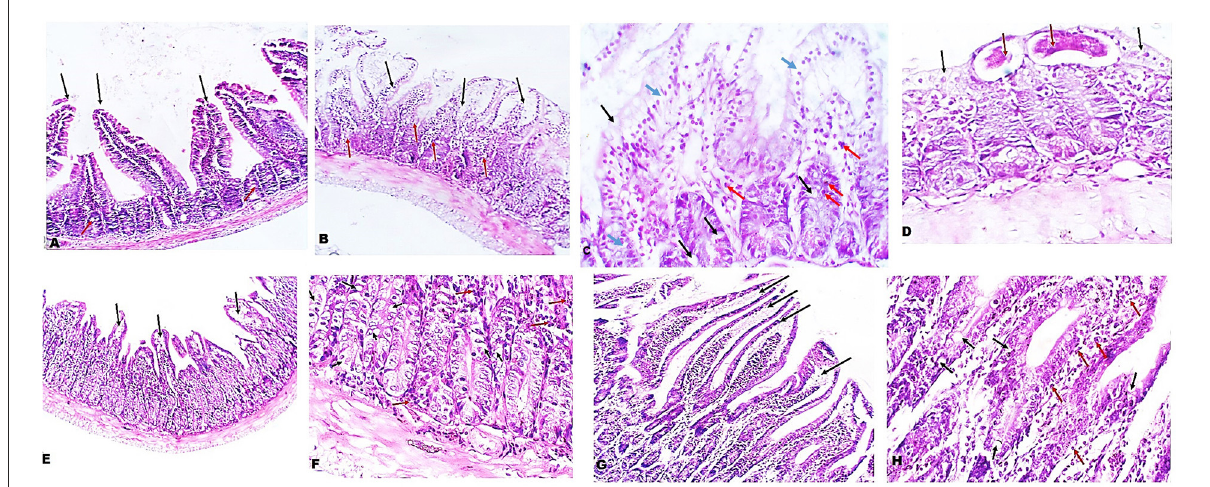
FIGURE2 Treatment with A. annua restored villi architecture and alleviated inflammation in intestinal tissues of T. spiralis -infected mice. (A) Representative image of small intestinal tissue of uninfected mice stained with H&E showing uniform villi and goblet cells (100x). (B) Representative image of small intestinal tissue of T. spiralis -infected untreated mice showing distorted degenerated edematous villi (black arrows) with significant mucosal inflammation (red arrows) (100x). (C) Higher magnification of (B) (400x) demonstrating edema in villi and lamina propria (blue arrows) and also high goblet cell numbers (black arrows) and inflammatory infiltrate composed mainly of eosinophils (red arrows) (D) Higher magnification of (B) (400x) with parasite on surface (red arrows) of distorted villi (black arrows). (E) Representative image of small intestinal tissue of infected mice treated with A. annua extract showing restoration of villi outline and reduced edema (black arrows). ( F) Higher magnification (400x) of (E) with similar number of goblet cells (black arrows) and lower inflammatory infiltrate than infected untreated mice (red arrows). (G). Representative image of small intestinal tissue of infected mice treated with albendazole showing protected villi and reduced edema (black arrows) compared to infected untreated mice. (H) Higher magnification (400x) of (G) showing reduced inflammatory infiltrate (red arrows) and similar frequency of goblet cell number (black arrows) compared to infected untreated mice.